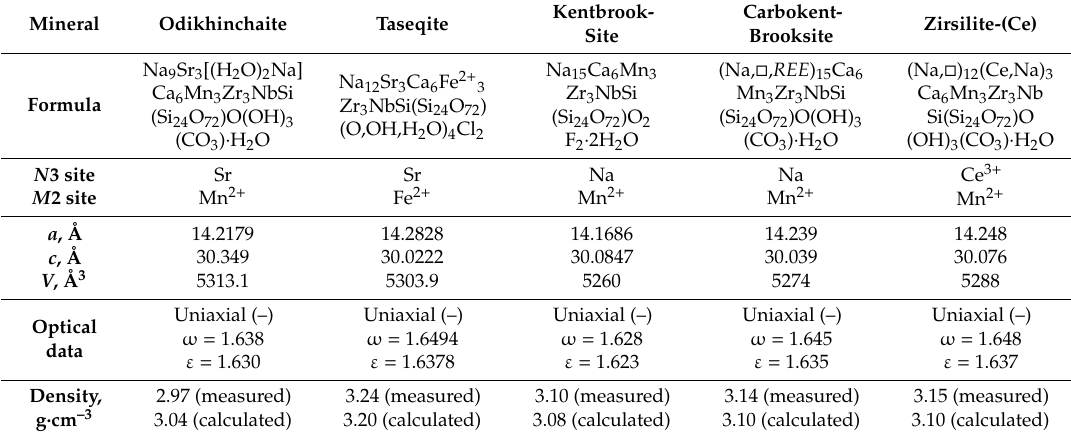
Table 6. Comparative data for odikhinchaite and some related eudialyte-group minerals *.